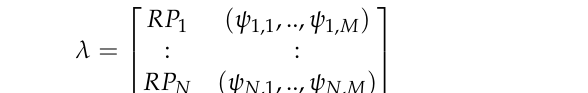
where P ( d ) denotes the RSS at point d in the ( x , y ) coordinate system, P ( d 0 ) denotes the RSS at reference distance (1 m), N denotes the path loss coefficient, ζ denotes the shadowing effect, and d denotes the distance between AP and RP. In the summation for wall and human attenuation factors, ι is the ι th physical barrier (walls in particular), υ represents the total number of barriers, and κ is the κ th human in the path, with Υ as the total number of humans through which the signal attenuated. The RSS values fluctuate over time due to many factors that contribute to signal fading. To counter temporal variations, RSS readings are taken over a period of time, which is defined mathematically